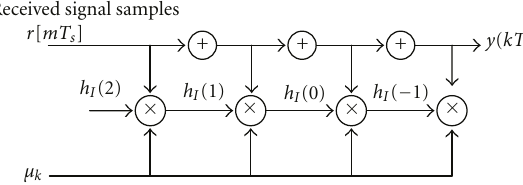
Figure 7: Preliminary structure for raised cosine interpolator with M = 4 T s